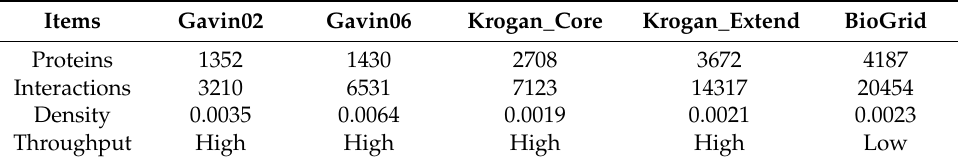
Table 2. Protein-protein interaction (PPI)